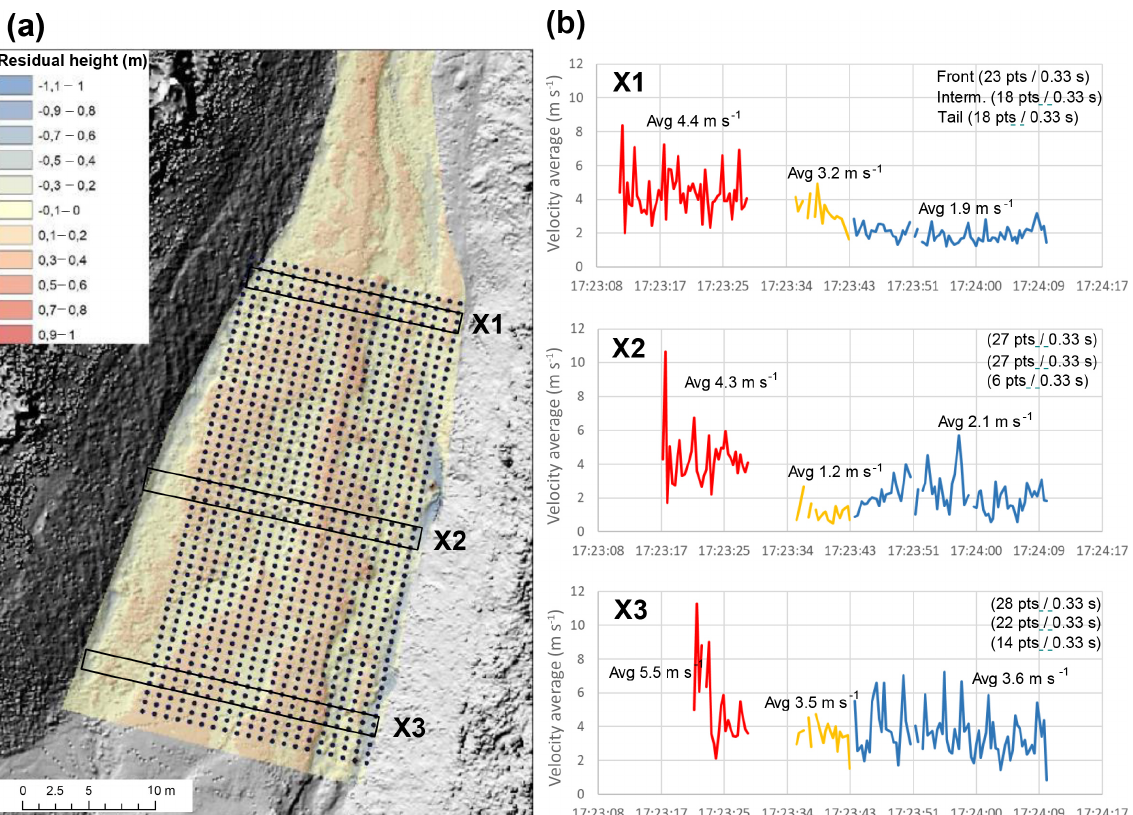
Figure 7. (a) Preliminary residual elevation of the channel bed at a 5m scale. The grid of LSPIV calculations is shown with cross section X1-3 outlined; (b) 2013 debris-flow LSPIV velocity time series (3fps) at three cross sections (X1, X2, and X3) with red (front), yellow (intermediate), and blue (tail). The velocity variation mostly represents the turbulence; however, some noise can come from low point density. The time interruption between the front and intermediate was initially made in the LSPIV analysis to clearly distinguish the two.